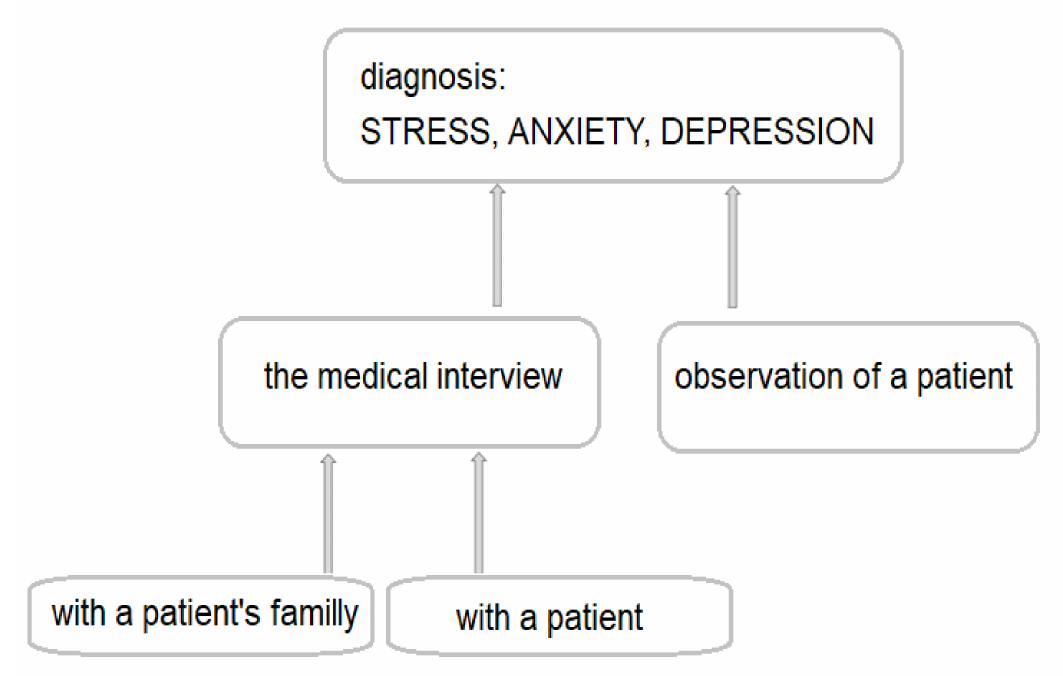
Figure 1. The procedure currently used to diagnose stress, anxiety and